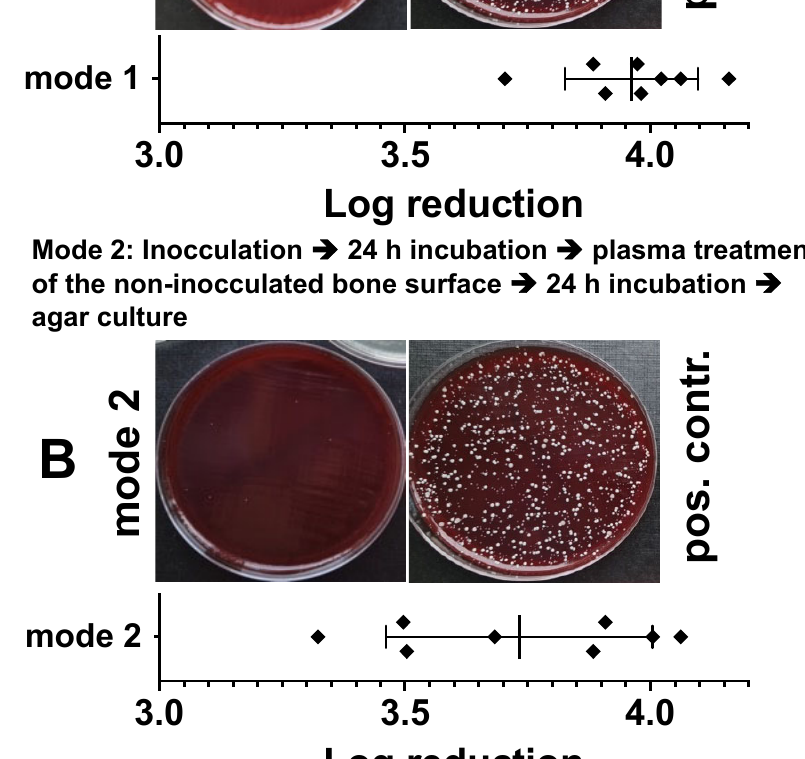
Figure 5. Characterization of the antibacterial effect of DBD plasma in a model of a bacterially infected bone preparation. Punch preparations from the pork shoulder blade were inoculated with the Staphylococcus epidermidis strain (1.5 × 10 6 ). After 24 h of incubation, the bacterially infected area ( A , mode 1) or the non-infected side ( B , mode 2) of the specimens were exposed to the DBD CAPs (5 min at 410 mW power dissipation in the discharge). After a further 24 h, the bacteria were detached and the reduction in the bacterial count (log 10 reduction of cfu/mL) was calculated. As positive controls (pos. contr.), the corresponding bone samples were treated identically with the bacteria, but were not exposed to plasma. Bars shown represent the mean ± S.D. of six individual experiments.